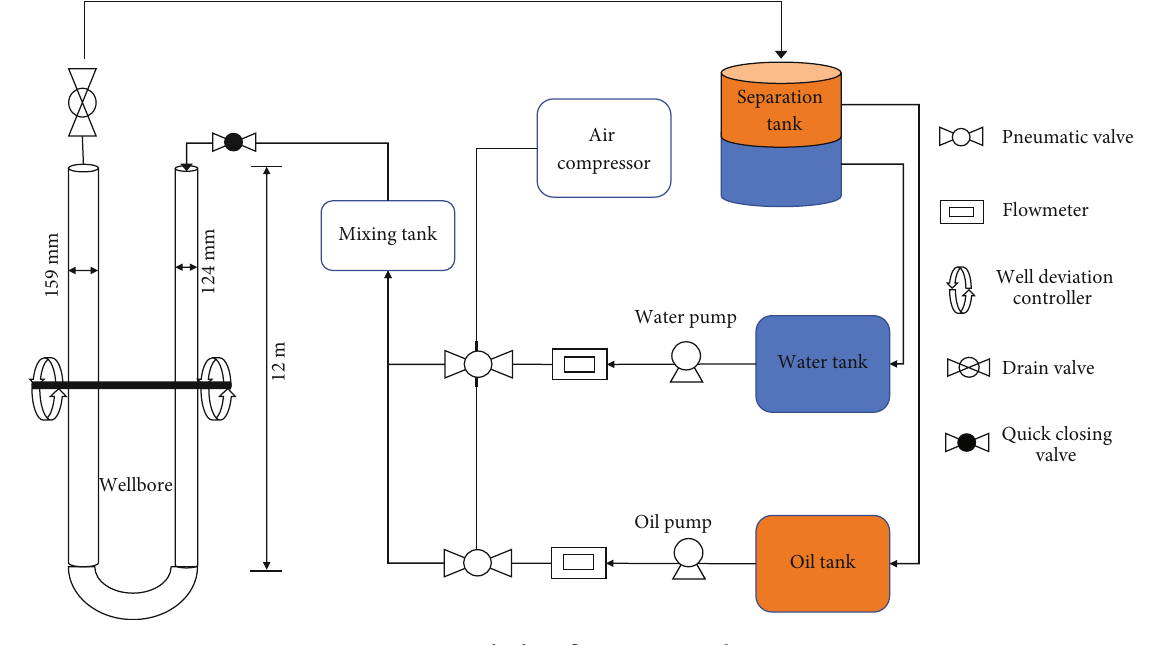
Figure 1: Multiphase fl ow experimental set-up.